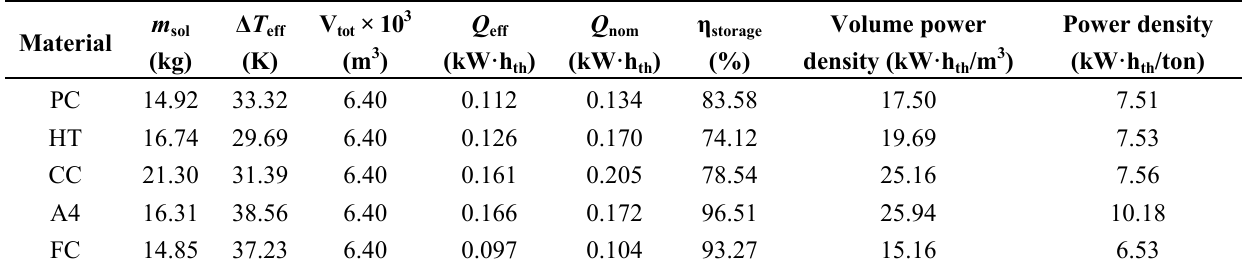
for selected tot